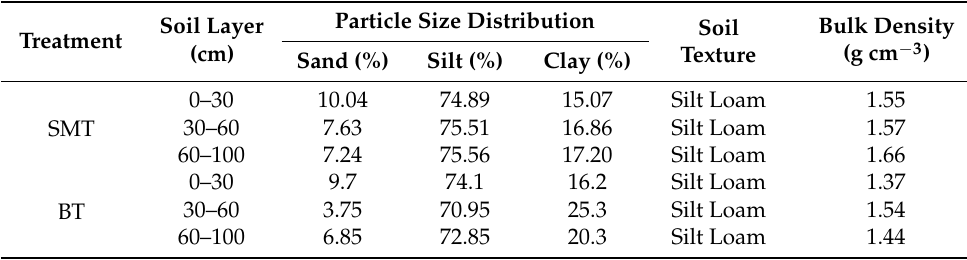
Table 1. Soil’s physical